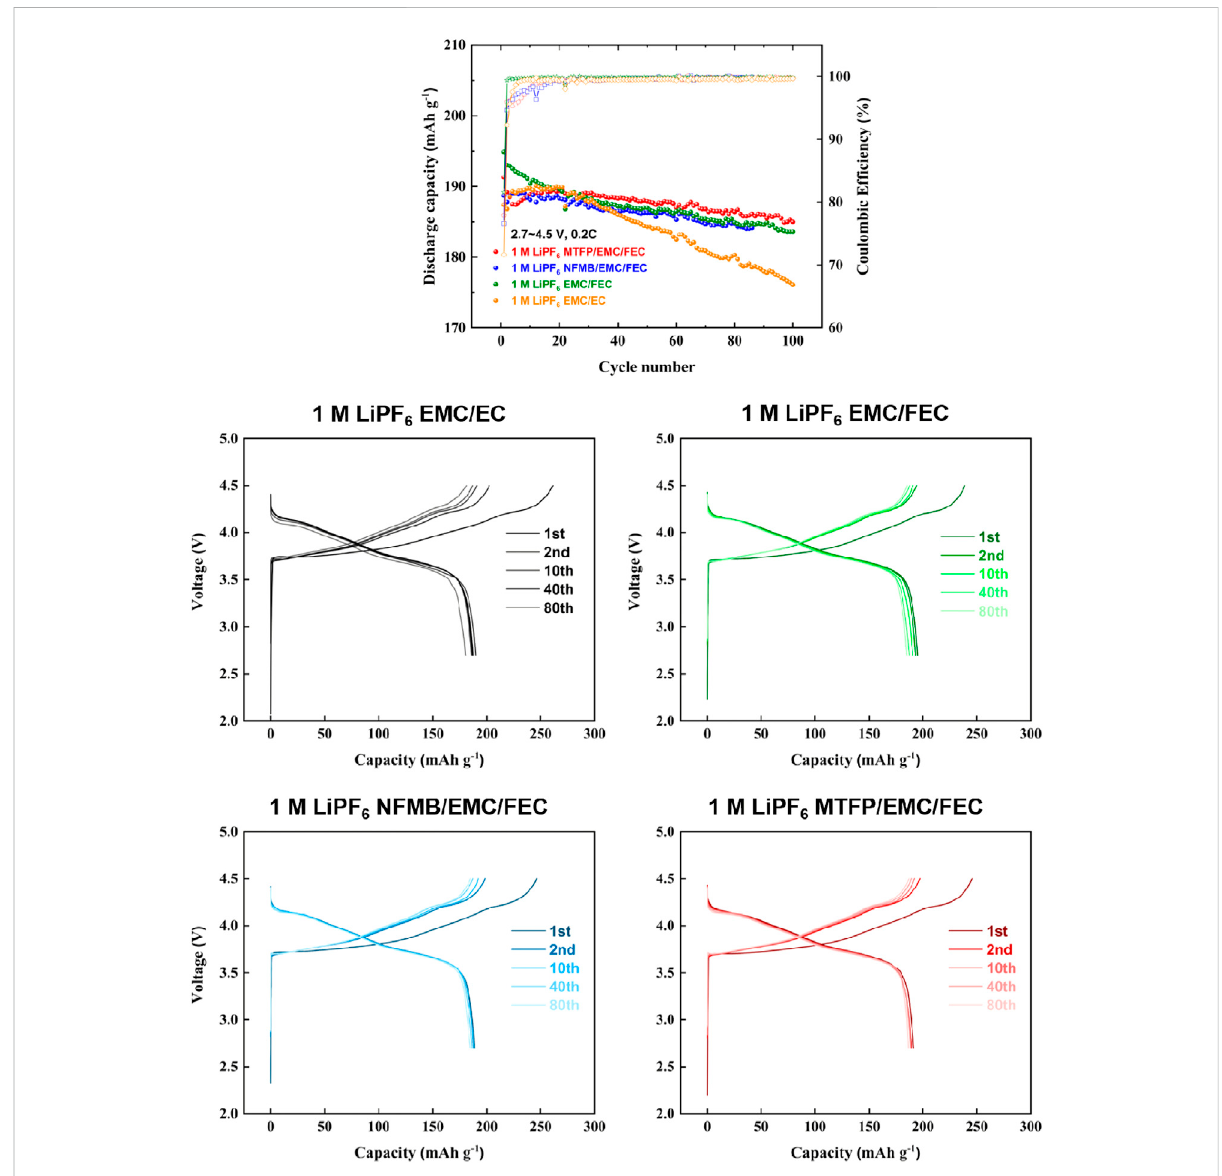
FIGURE 4 Charge-discharge cycling performances of Li/NCM811 coin-cells assembled with different electrolytes at a cut-off voltage of 2.7 – 4.5 V and a current density of 0.2